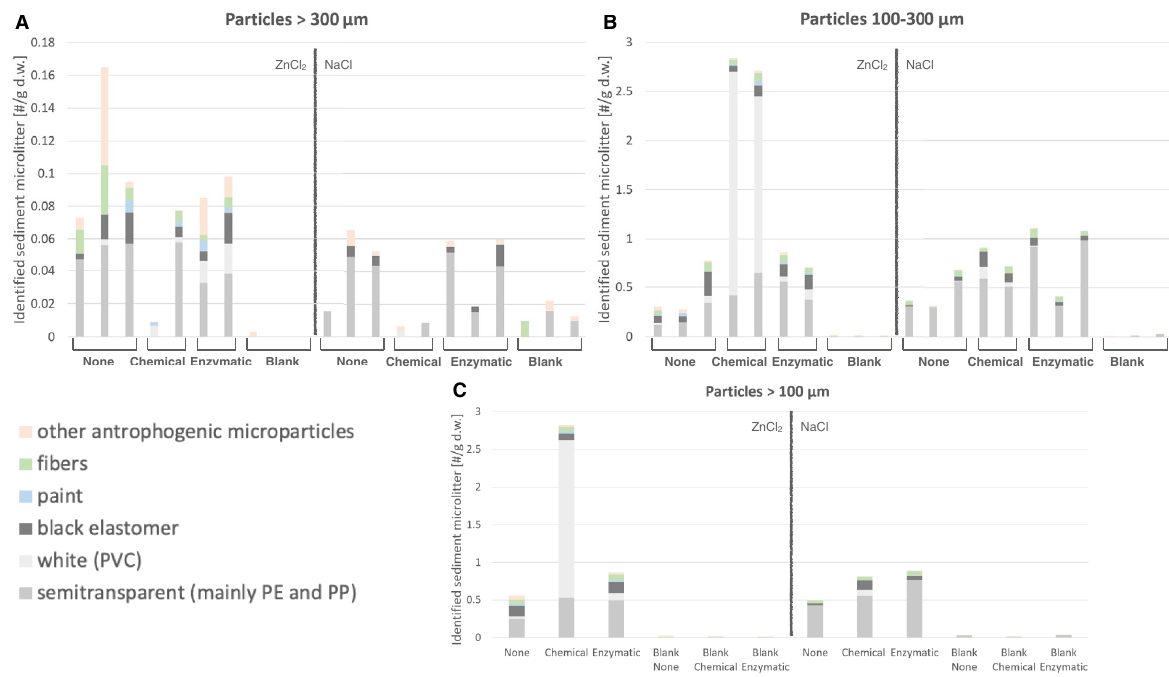
Figure 4. Particle concentration of anthropogenic microparticles for particles ( A ) larger than 300 μm, ( B ) between 100 and 300 μm, and ( C ) larger than 100